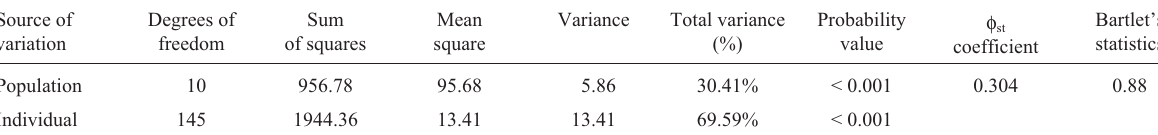
Table 3 - Analysis of Molecular Variance (AMOVA) based on 82 random amplified polymorphic DNA (RAPD) loci for all populations of Eupemphix nattereri from Central Brazil.